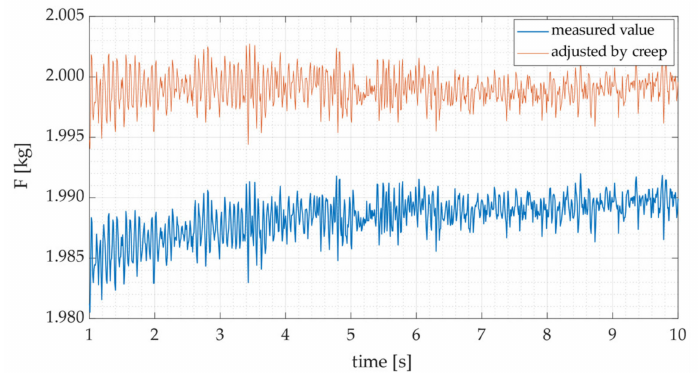
Figure 13. Force measured and adjusted by creep for 1 ≤ t ≤ 10